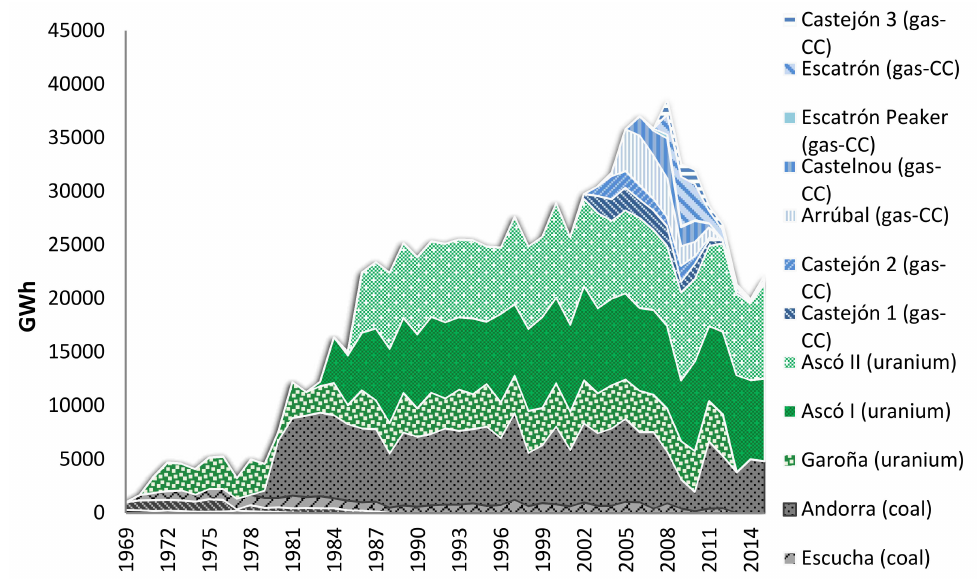
Figure 3. Evolution of thermal power generation by power plant and technology in the Ebro River basin, 1969–2015. Source: own design using UNESA’s and REE’s annual